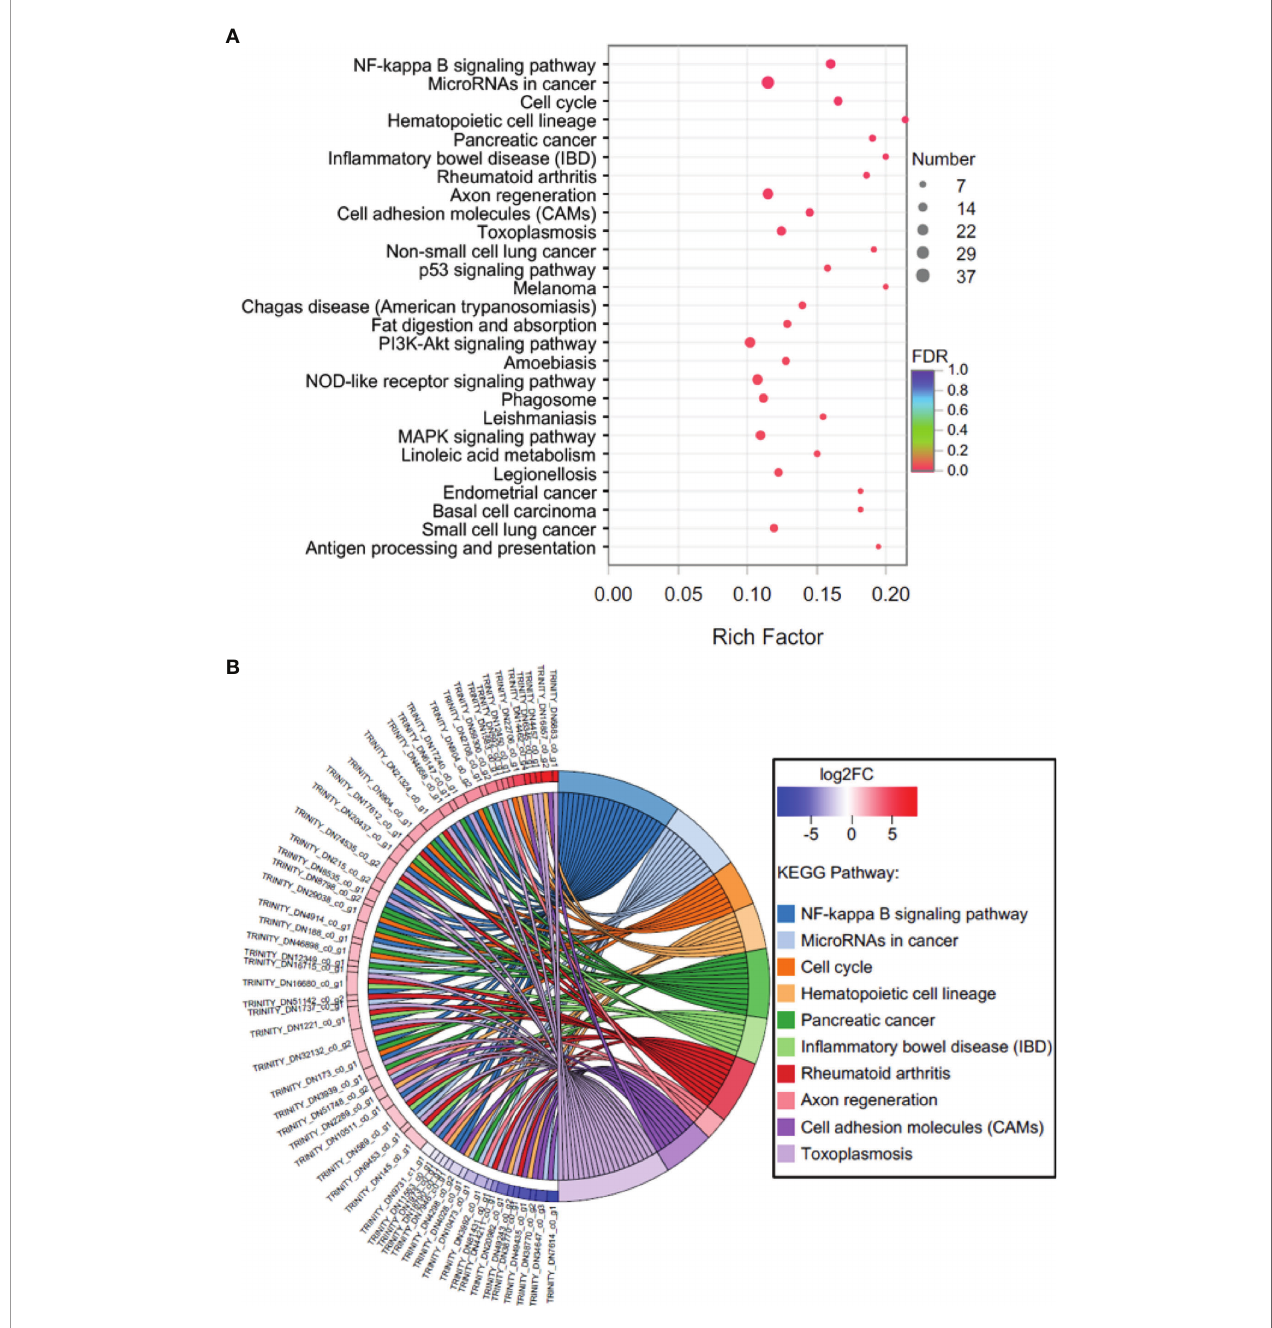
FIGURE 5 | KEGG enrichment analysis of DEGs in C vs. LS. (A) Bubble diagram, (B) Enrichment chord